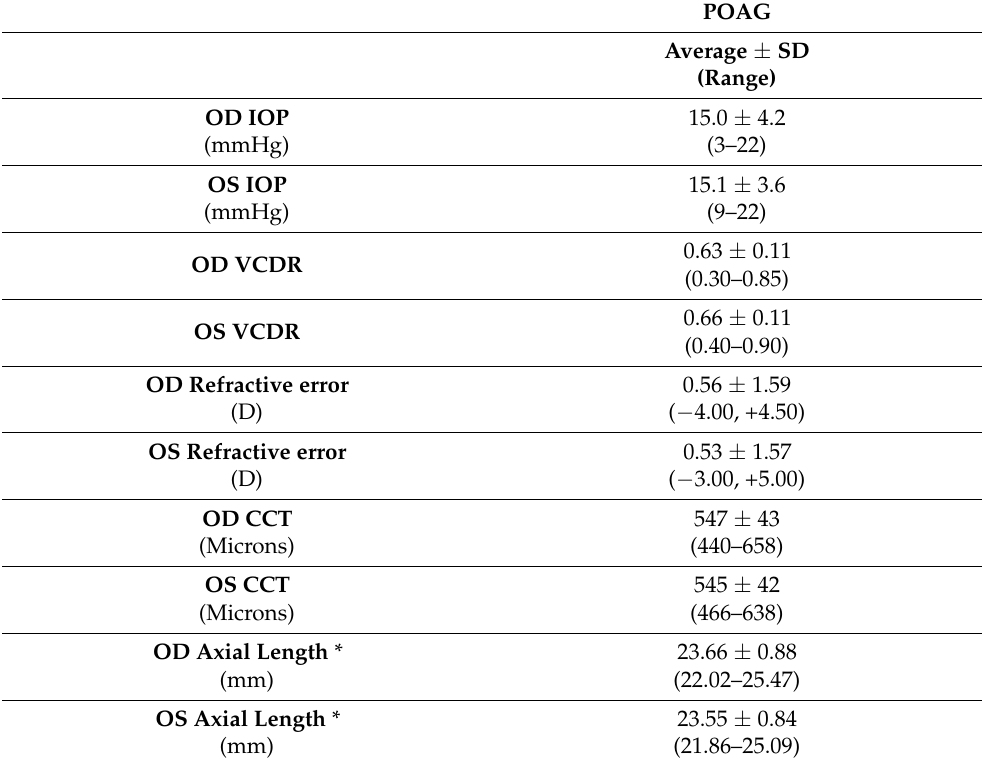
Table 4. Quantitative eye measurements for POAG-affected GGLEAM study participants. Measure- ments were obtained from eye exams performed at the Ohio Eye Associates office for 37 POAG- affected individuals. IOP: intraocular pressure. VCDR: vertical cup-to-disc ratio. OD: oculus dexter (right eye). OS: oculus sinister (left eye). Refractive error: Spherical equivalent from distance refraction. D: diopters.